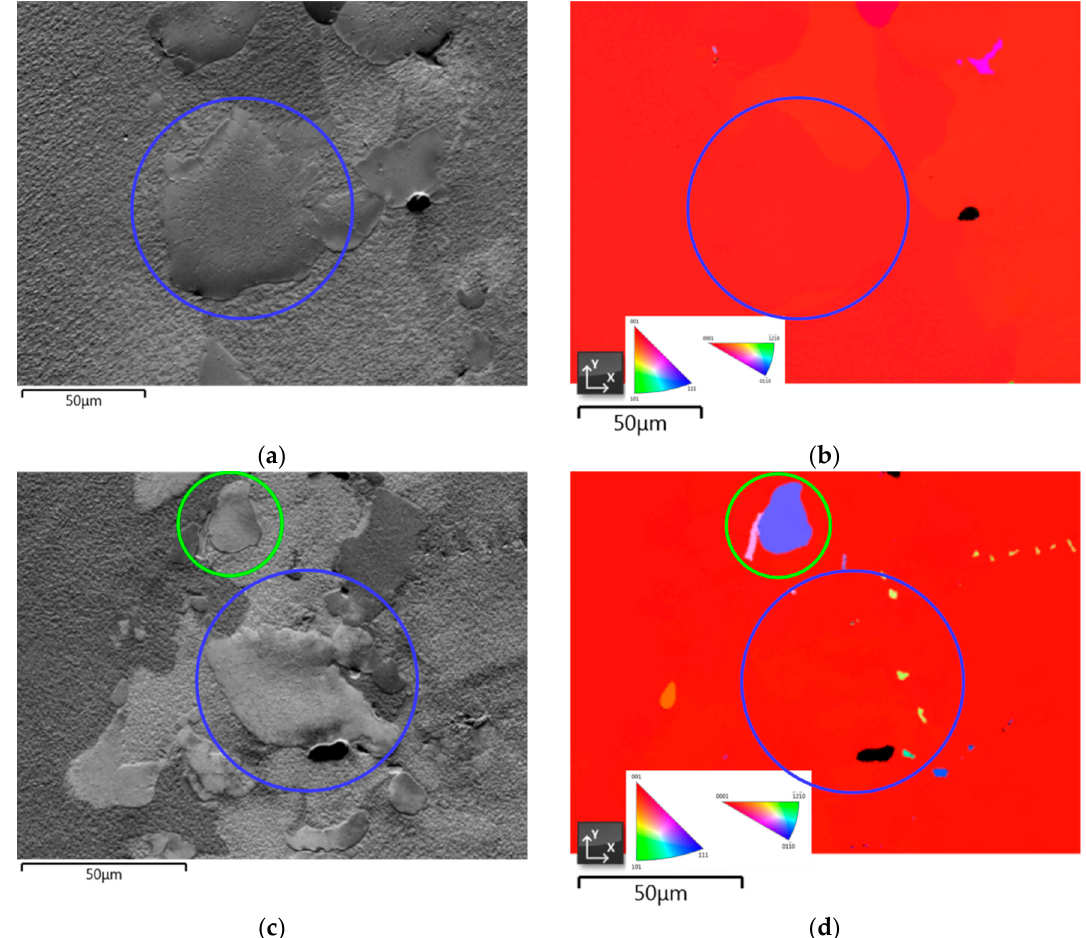
Figure 10. EBSD analysis results of LC-SC samples of CMSX-6 + 0.03C showing: ( a , c ) SEM images; ( b , d ) IPF mapping directionally solidified at 0.13 K · s − 1 ( a , b ) and 0.4 K · s − 1 ( c , d ). The blue circles represent the E γ -type eutectic islands, while the green circle refers to the E MC type.